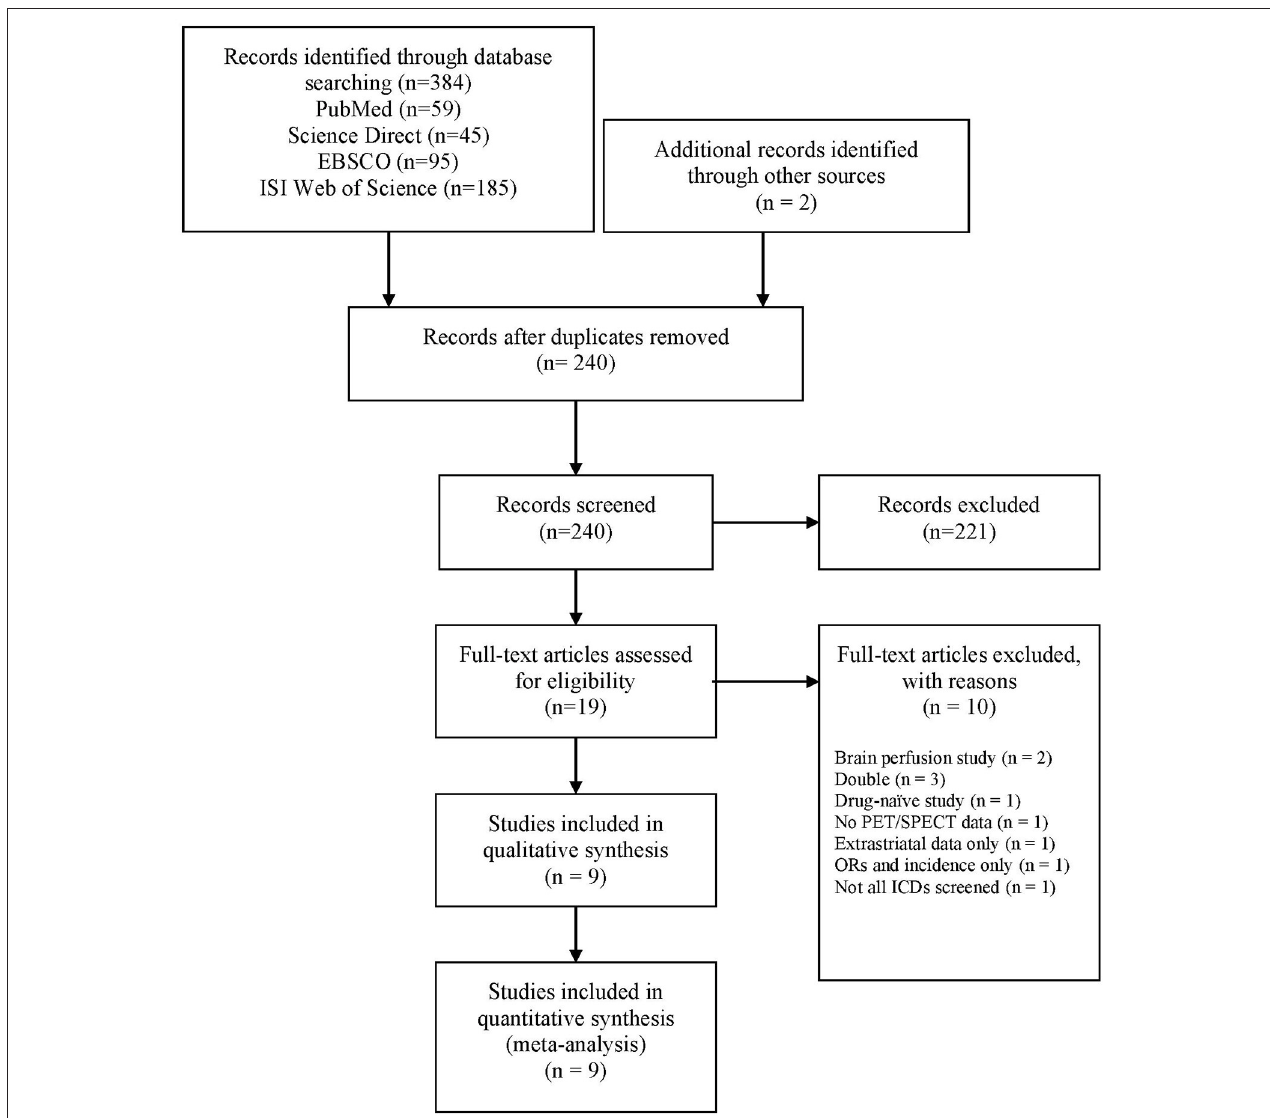
FIGURE 1 | PRISMA diagram of the study (www.prisma-statement.org). ICD, impulse control disorder; ORs, odds ratios; PET, positron emission tomography; SPECT, single-photon emission computed